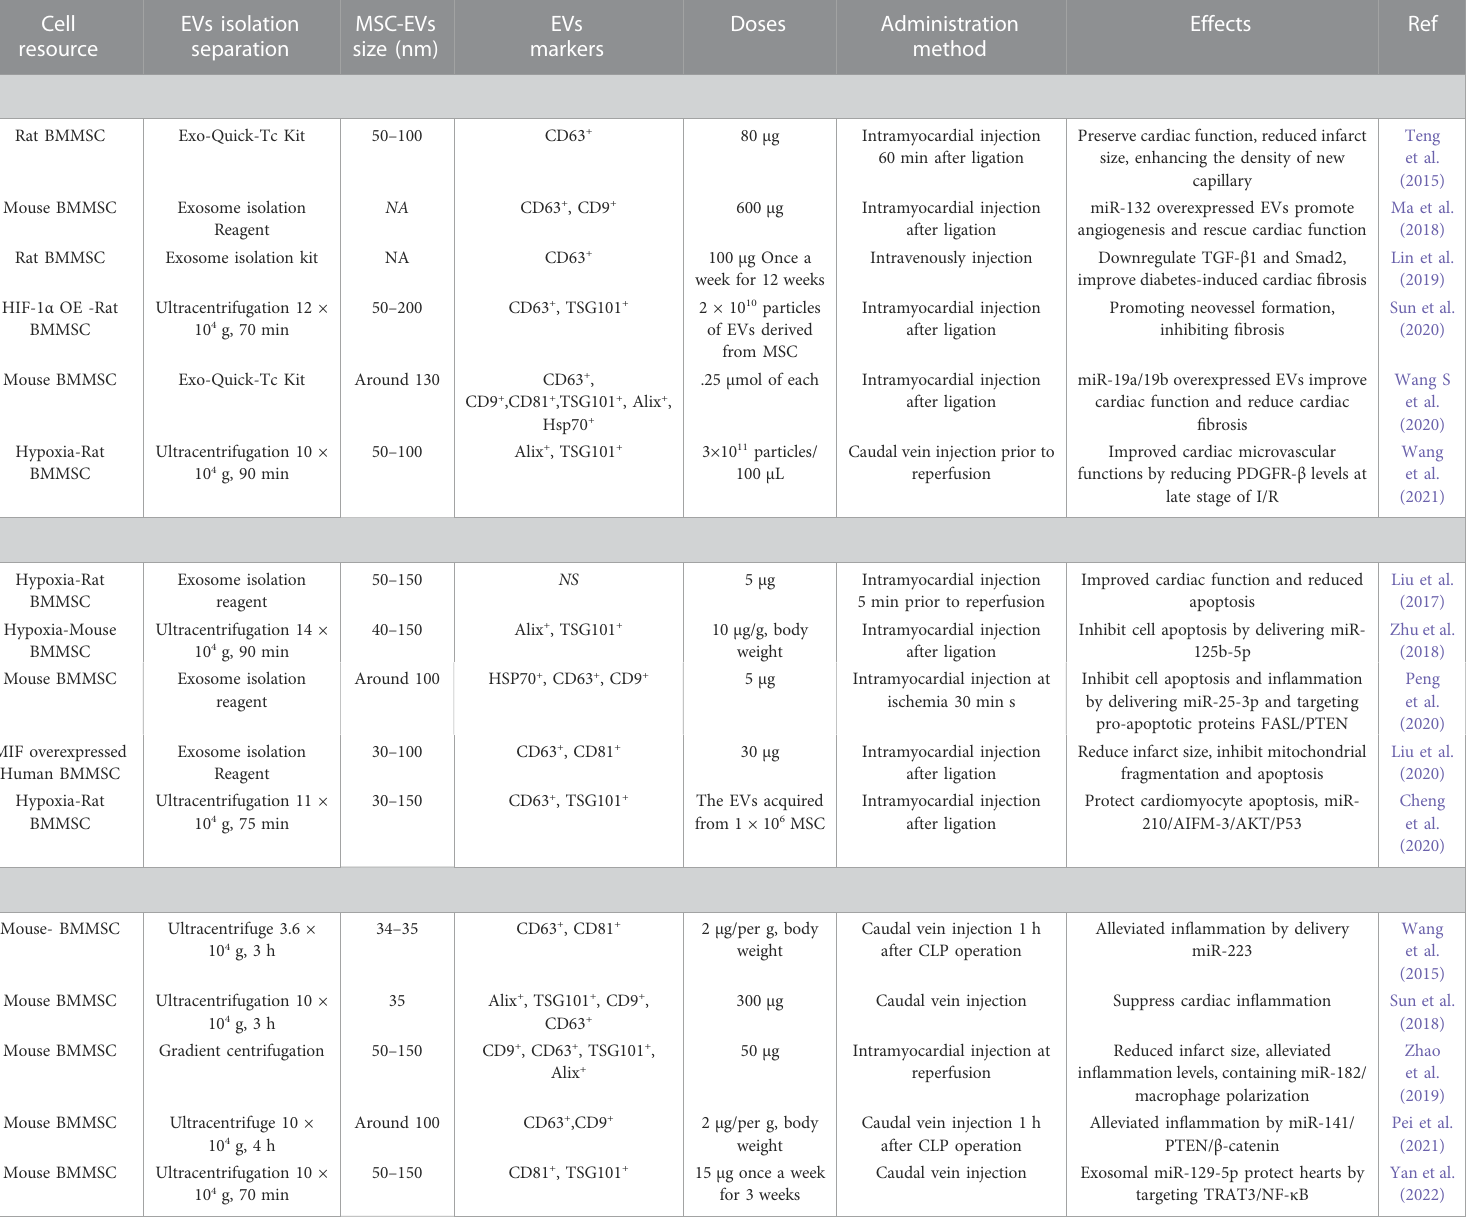
TABLE 2 Pre-clinical studies of using EVs derived from BMMSC in